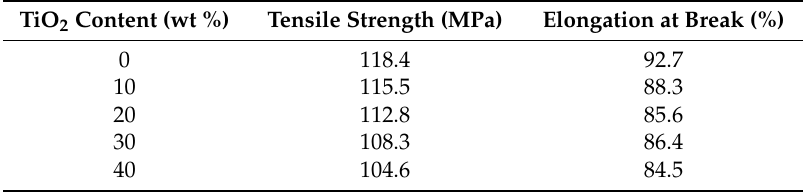
Table 2. Mechanical properties of PP/TiO 2 composite membranes with different TiO 2